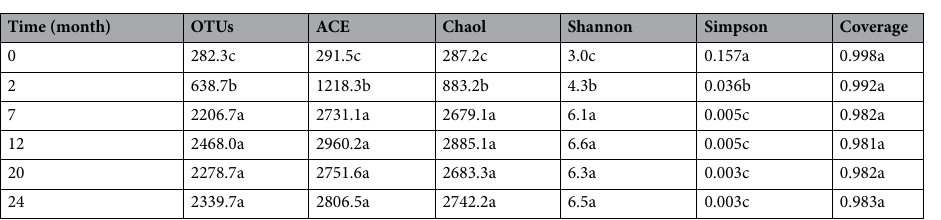
Table 1. α-diversity index of bacterial communities in straw decomposition. The data represents the mean ( n = 3). Different lower-case letters in one column indicate significant differences among treatments (P < 0.05).